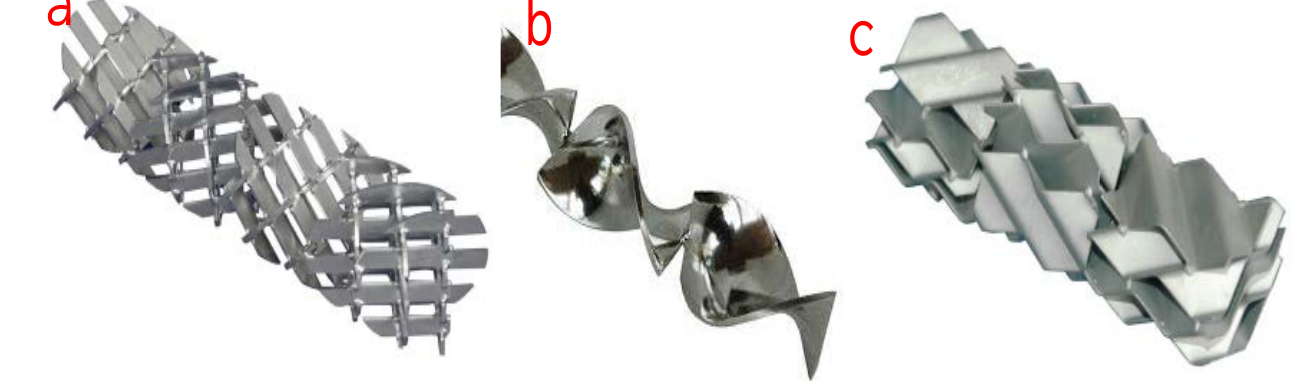
Figure 8. Different configurations of static mixers. ( a ) X-grid static mixer; ( b ) helical twist static mixer; ( c ) corrugated plate static mixer.